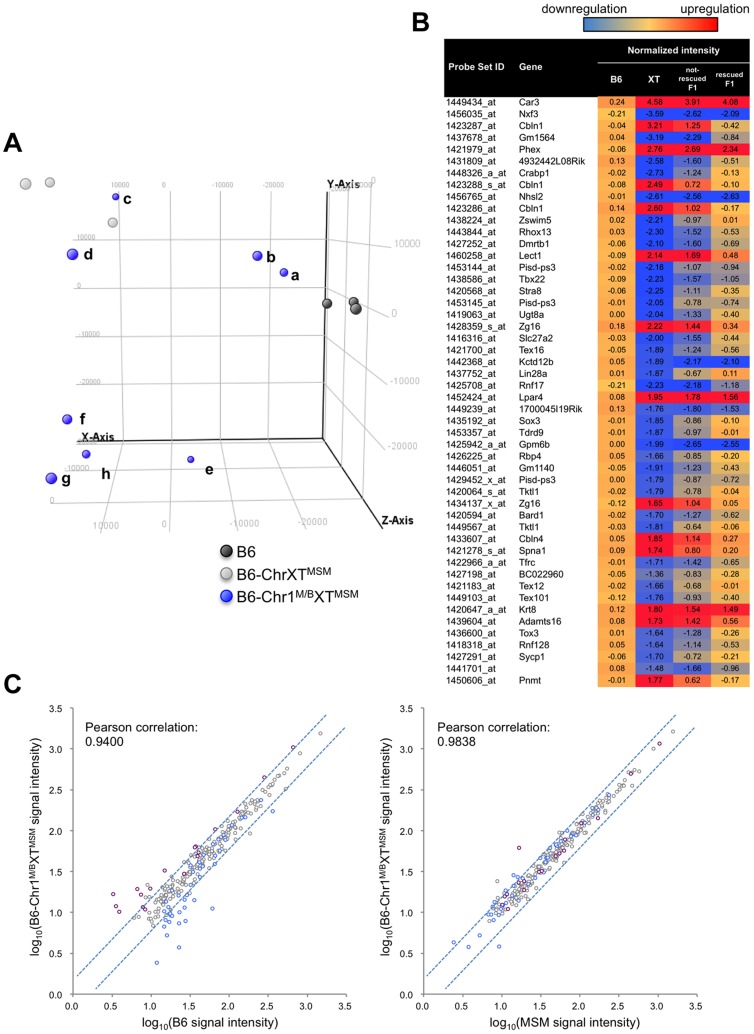
Transcriptional profiling of B6-Chr1MSM/B6XTMSM testes.(A) PCA score plots using global gene expression profiles of B6, B6-ChrXTMSM and B6-Chr1MSM/B6XTMSM individuals. Coordinate values of B6-Chr1MSM/B6XTMSM individuals (a∼h) were dispersed between two clustered values of the B6 and B6-ChrXTMSM individuals. Note that two B6-Chr1MSM/B6XTMSM individuals (a and b) were located near the B6 individuals. X-axis = PC1: PCA Component 1 (19.6% variance); Y-axis = PC2: PCA Component 2 (17.9% variance); Z-axis = PC3: PCA Component 3 (11.1% variance). (B) Top 50 ranking of transcripts in B6-ChrXTMSM testes with expression levels that were different from those in B6 testes. Heatmap shows the transcripts that were downregulated (blue) or upregulated (red) relative to those in B6. Each number indicates the fold change of expression relative to B6 controls. Two types of B6-Chr1MSM/B6XTMSM, restored and not-restored types, showed different levels of restoration. (C) Comparison of the logarithm transformed signal intensities of distal-X-linked transcripts in B6-Chr1MSM/B6XTMSM testes with those in B6 or MSM. Y-axis is signal intensity of B6-Chr1MSM/B6XTMSM, and X-axis is signal intensity of B6 (left) or MSM (right). Upregulated or downregulated transcripts in B6-ChrXTMSM testes relative to B6 are indicated by purple and blue circles, respectively. Dotted blue lines represent the borders of a 1.5 fold change for upregulation or downregulation.